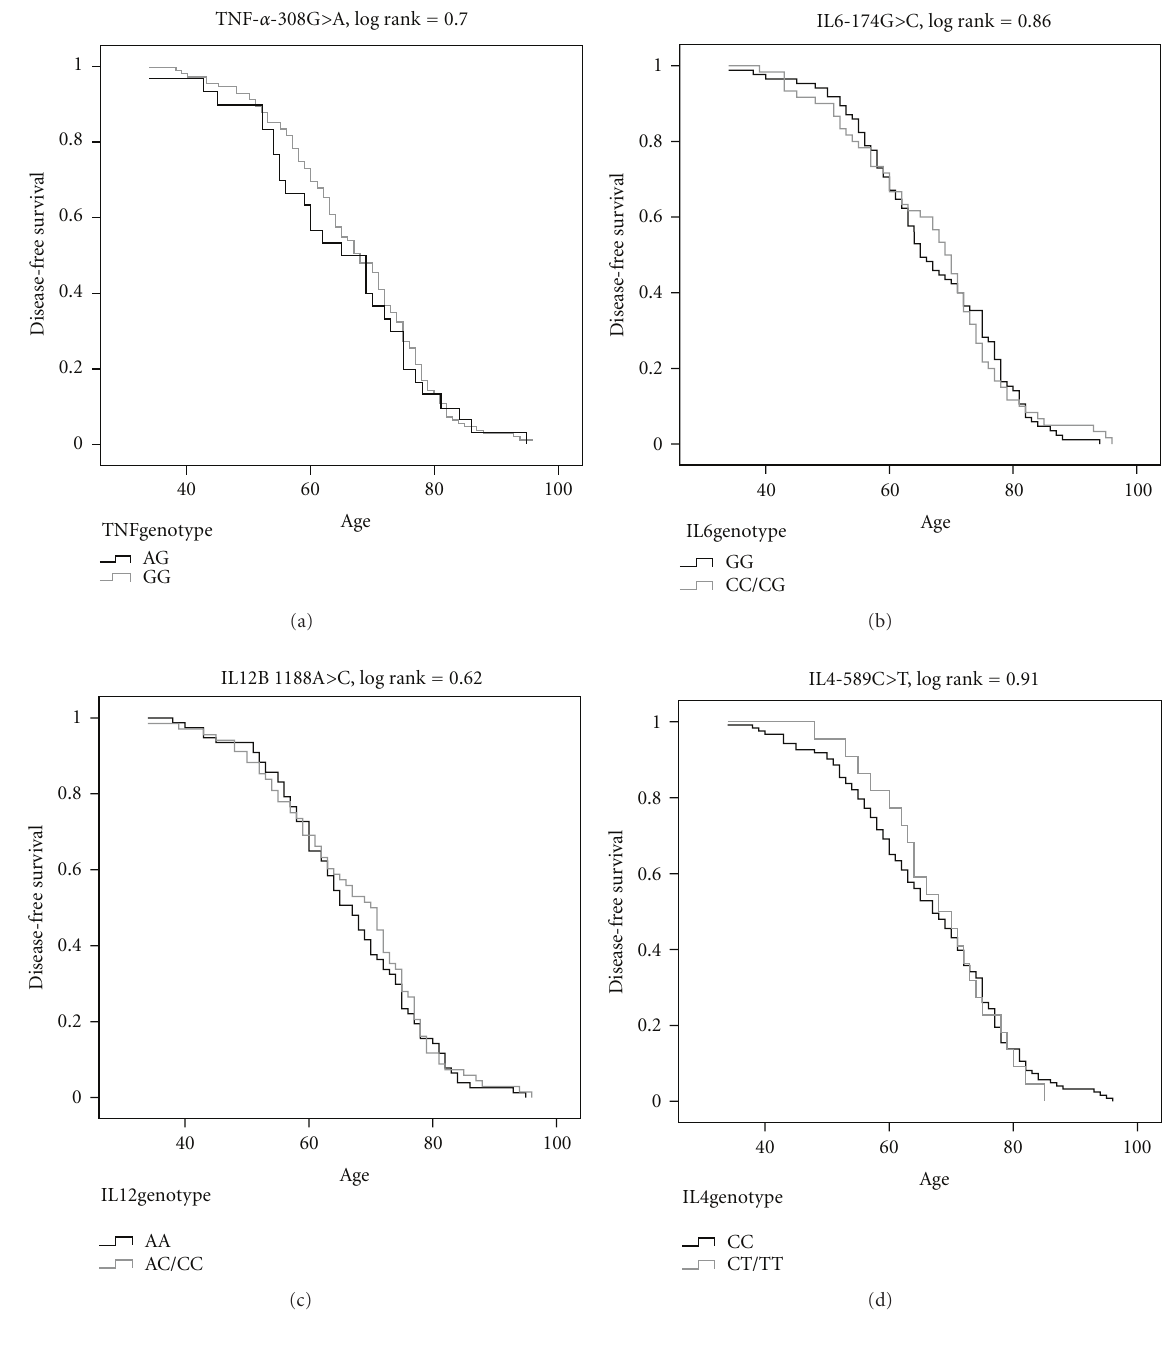
Figure 1: Kaplan-Mayer curves for the disease-free survival analysis, according to the studied inflammatory genotypes.